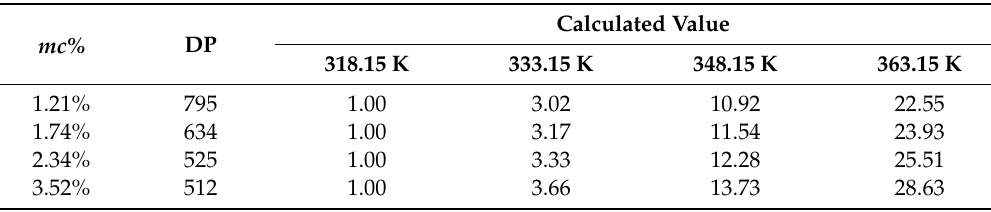
Table 6. Calculation results of the prediction amplitude-shift